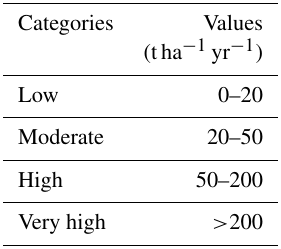
Table 7. FAO criteria for assigning ecoregions to different cate- gories of potential soil